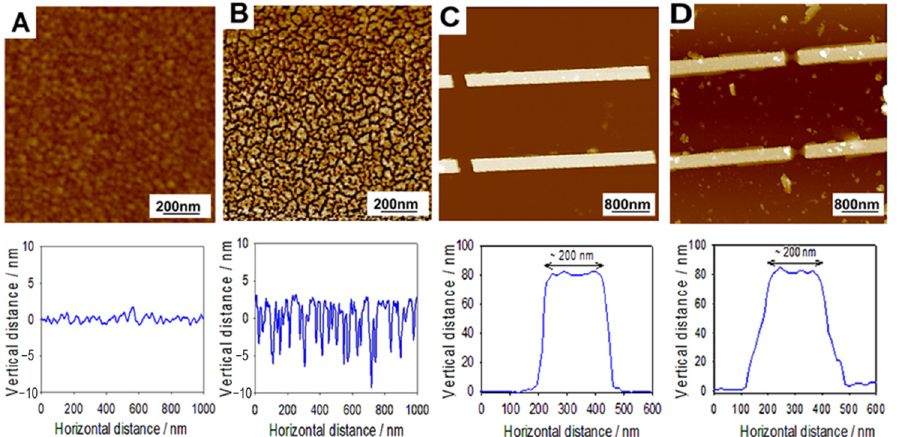
Figure 2. ( A , B ) Typical AFM height images, obtained in Peak Force Tapping mode (ScanAsyst) and in dry state, along with corresponding cross-section profiles of 7 nm Au layer (z-scale 10 nm) and ( C , D ) Au nanoantennas (z-scale 200 nm). ( A , C ) before and ( B , D ) after DPPTE lipid immobilization followed by the chloroform rinsing. The transversal cross-section is presented for the Au